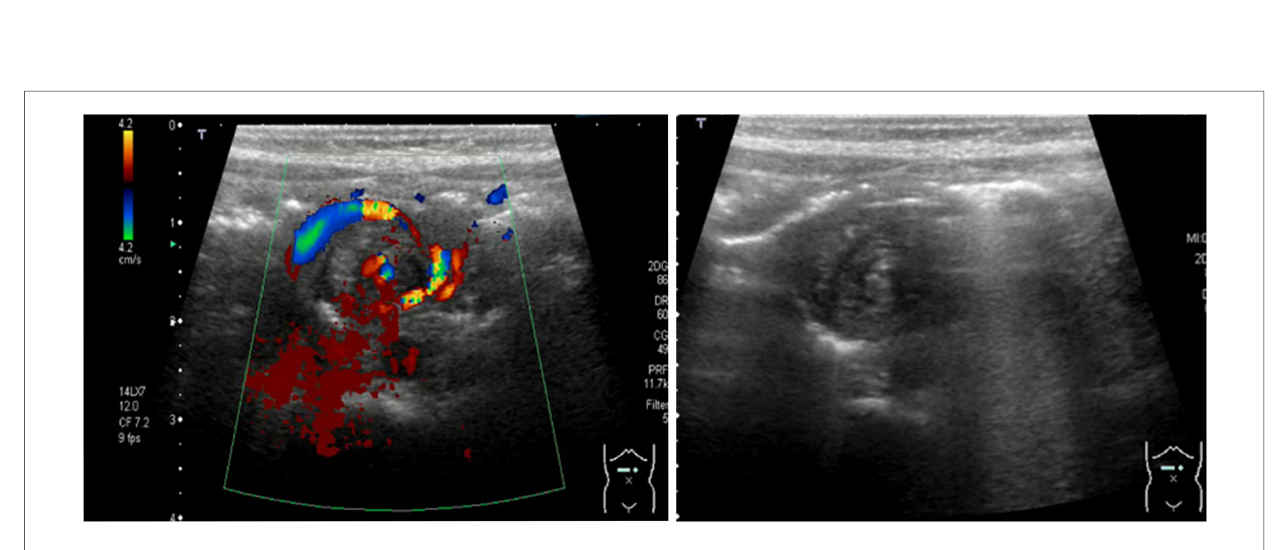
FIGURE 11 The sonographic appearance of neonatal midgut volvulus — the whirlpool sign. Color Doppler. Grayscale imaging.